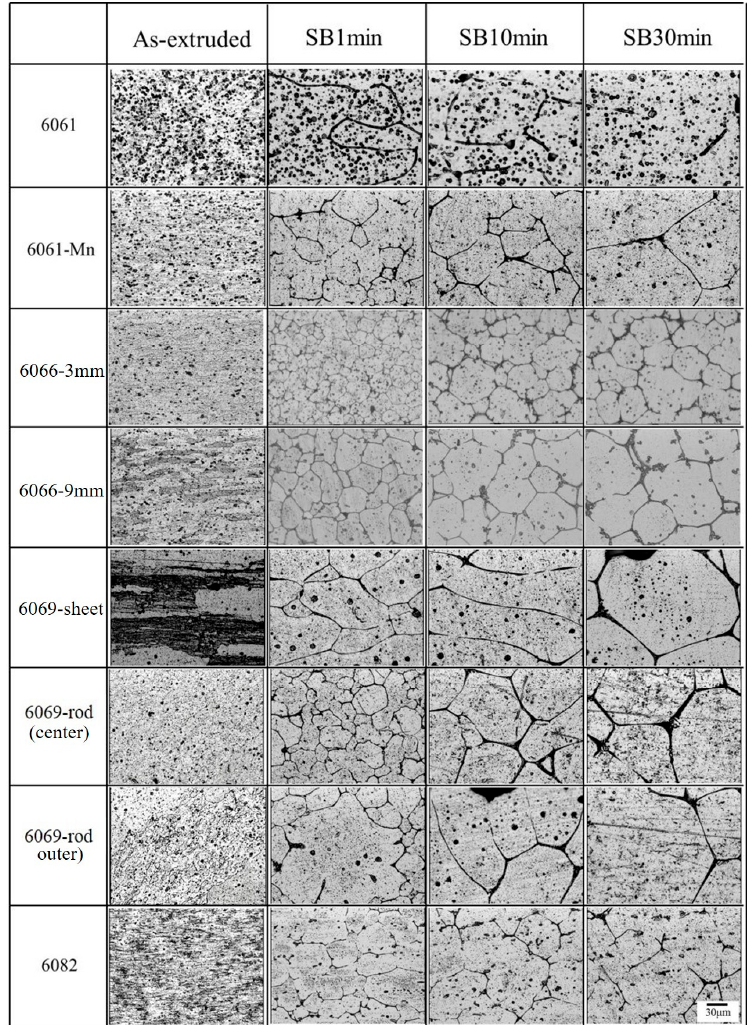
Figure 4. Microstructural evolution of Al–Mg–Si alloys via salt bath.